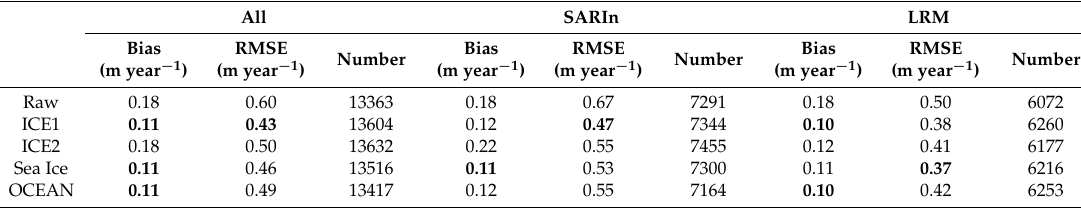
Table 2. Comparison between SARAL and ICEBridge (airborne topographic mapper (ATM) L4 data). For each waveform retracking algorithm, the bias and RMSE of the differences between the SARAL and ATM L4 data are given. The minimum values are highlighted in